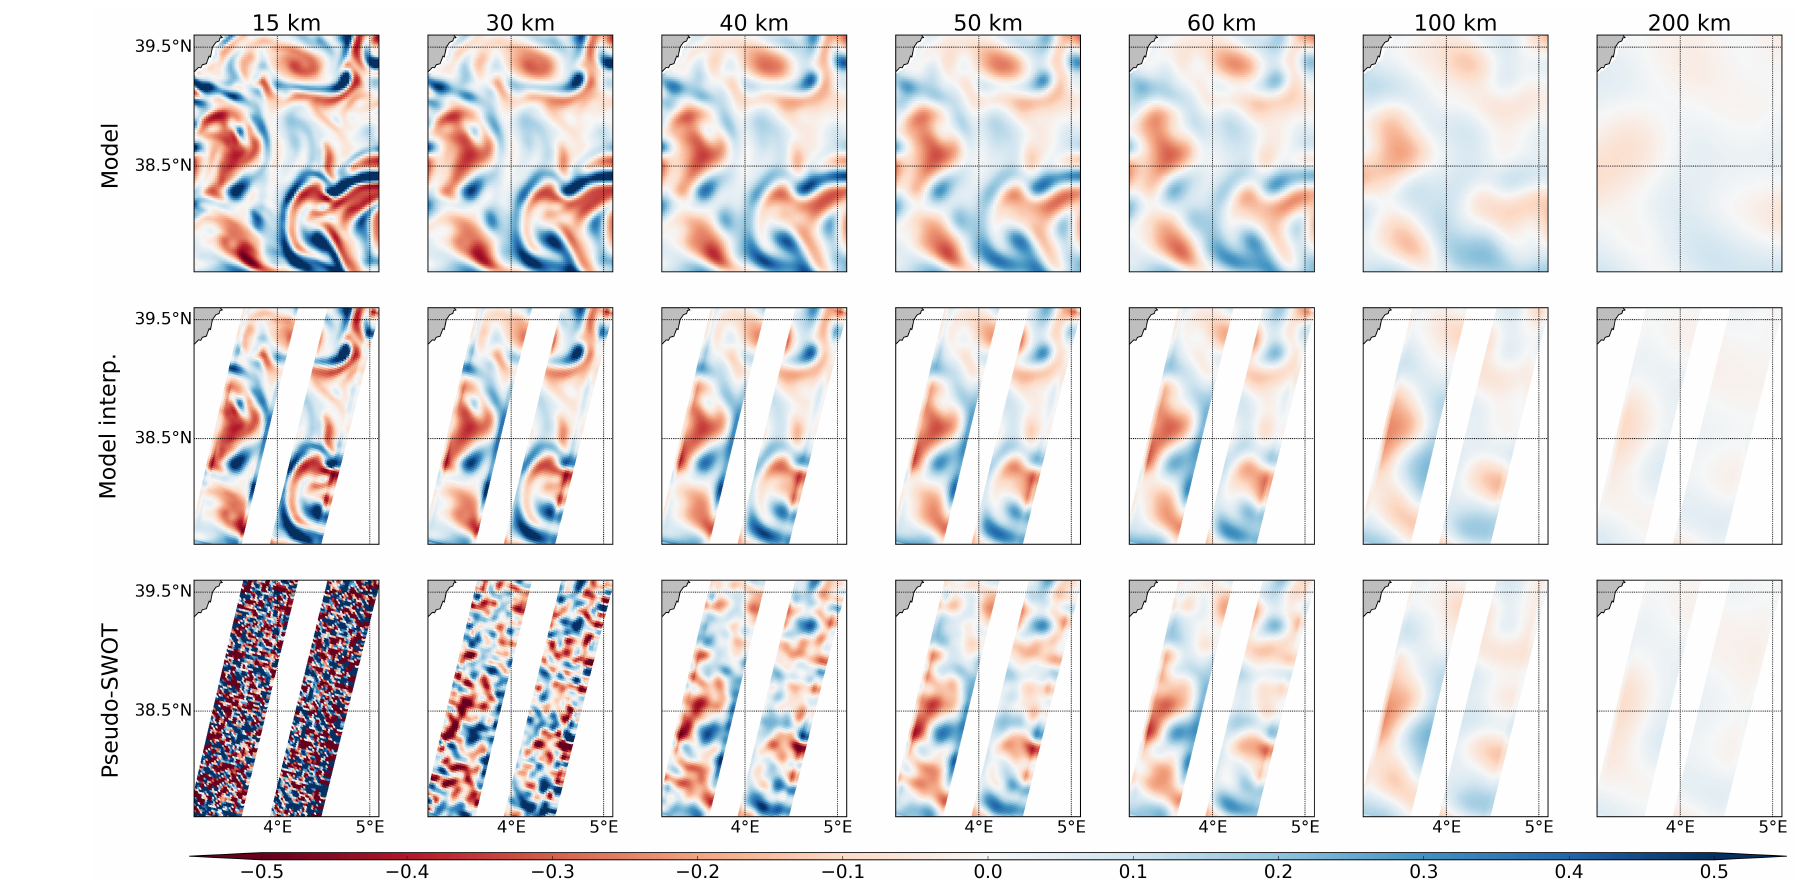
Figure 12. Relative vorticity normalized by f on 3 February 2009 corresponding to pass 168 of cycle